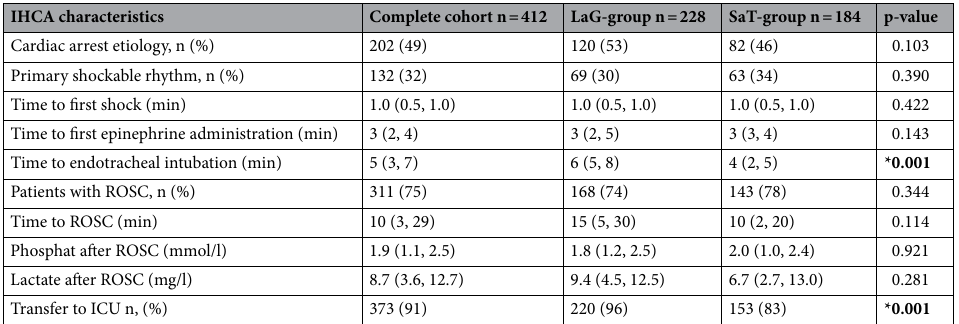
Table 2. IHCA characteristics. Categorical variables are reported as absolute values and percentages, whereas continuous data are expressed as median with interquartile range. * indicates p ≤ 0.05 between LaG group and SaT group. Significant values are in bold. IHCA In-hospital cardiac arrest, LaG Load-and-Go, SaT Stay-and- Treat, ICU Intensive care unit, ROSC return of spontaneous